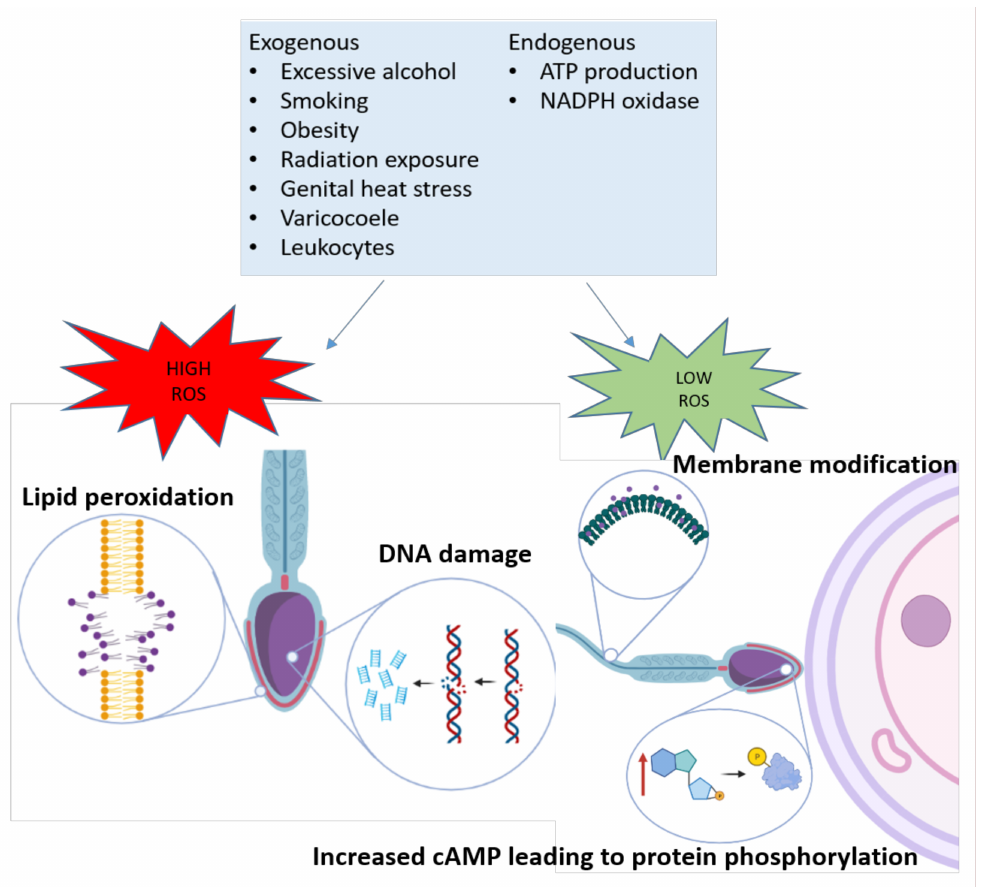
Figure 1. Sources of ROS generated exogenously and endogenously in sperm. At low levels, ROS contributes to successful fertilization by increasing membrane fluidity through cholesterol exudation and through tyrosine phosphorylation of target proteins required for fertilization. Certain ROS species directly inhibit tyrosine phosphatases and others contribute to the activation of cyclic adenosine monophosphate (cAMP), leading to protein kinase A activation and phosphorylation of target